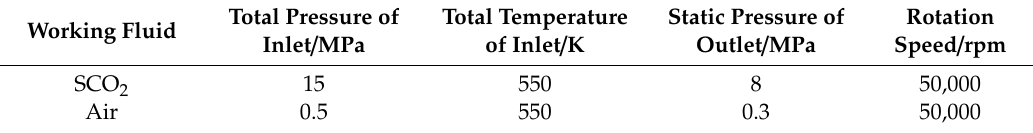
Table 2. Boundary conditions of the calculated cases.